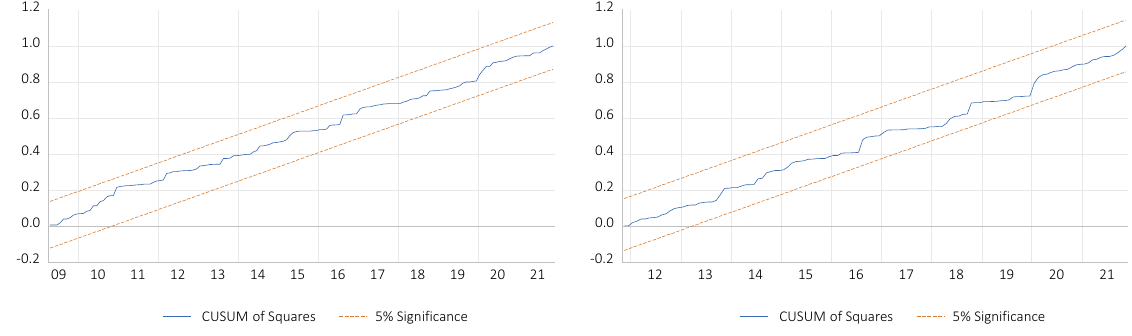
Figure 3. CUSUM of the square stability